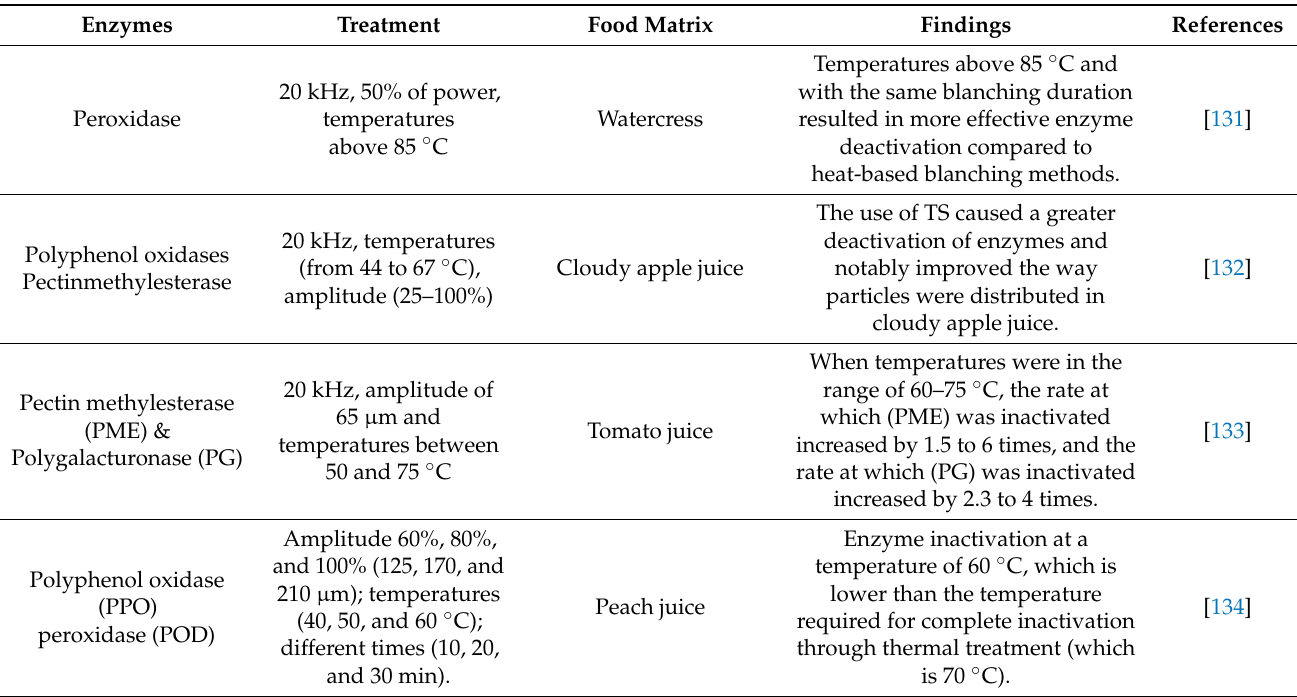
Table 3. Studies of thermosonication (TS) effects on inactivation of enzymes in some food matrix. Enzymes Treatment Food Matrix